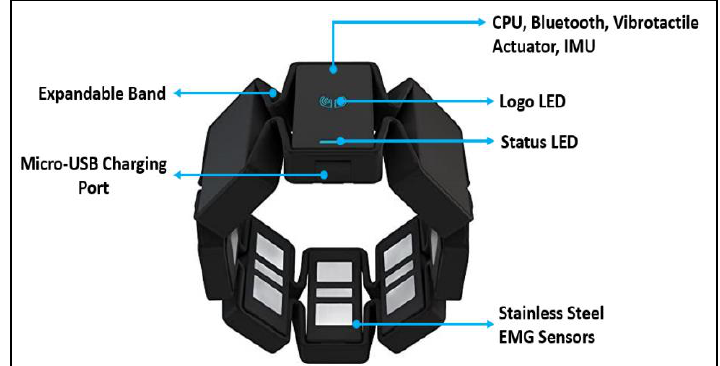
Figure 3. The MYO Gesture Armband [11]